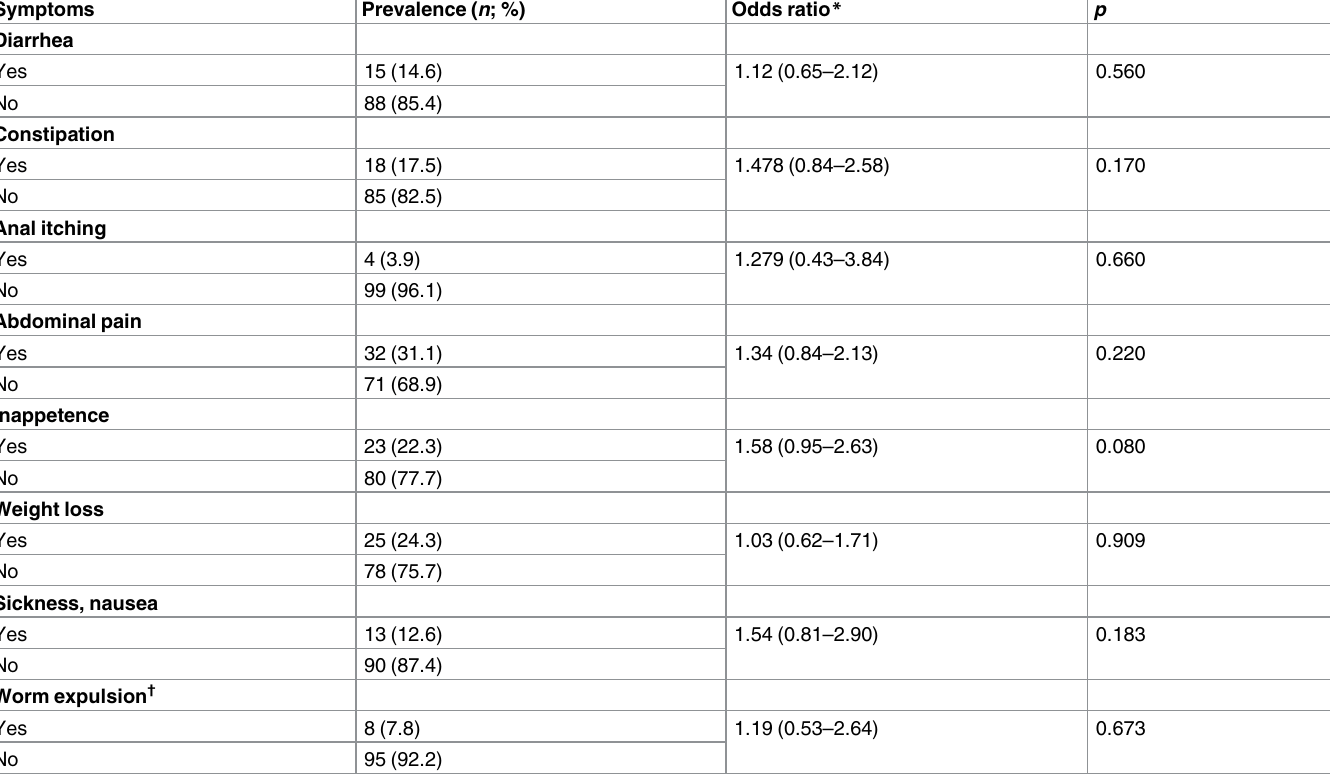
Table 5. Symptoms reported by inmates with positive parasitological stool tests. Mato Grosso do Sul, Midwest Brazil ( n =